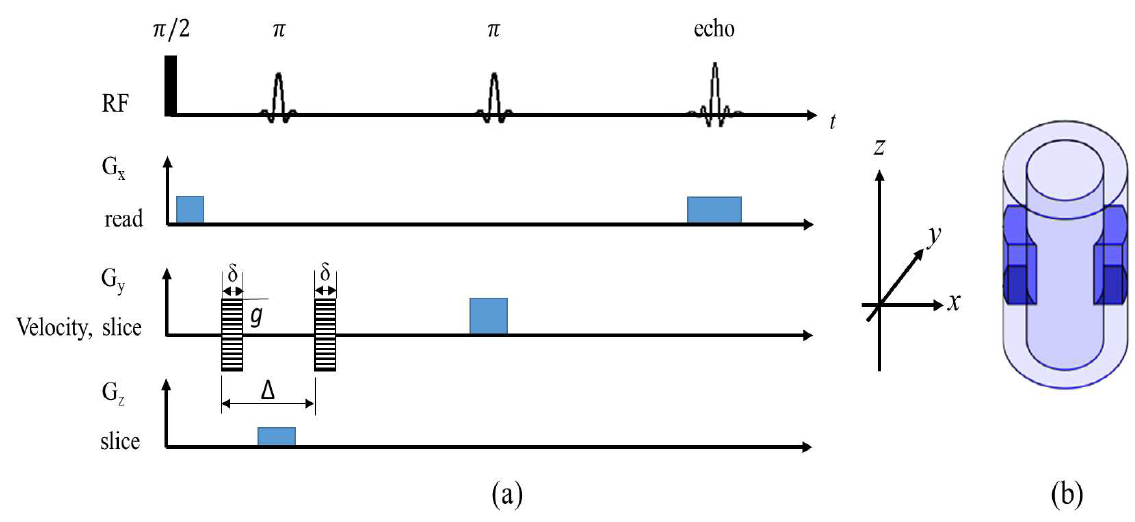
Figure 2: (a) Timing diagram for PGSE motion encoding with double slice selection. (b) A schematic of the Couette. The imaging region, consisting of a 10 mm thick slice along the vorticity direction ( z -axis) and a 1 mm thick slice along the velocity direction ( y -axis), is shown in the shaded section. The 1D image had a spatial resolution of 59 µ m/pixel and was acquired across the fluid gap ( x -axis). Velocity was measured in the direction of flow ( y -axis) with ∆ = 11 ms and δ = 1 ms. The inner cylinder, the rotor, is rotating and the outer cylinder, the stator, is stationary.